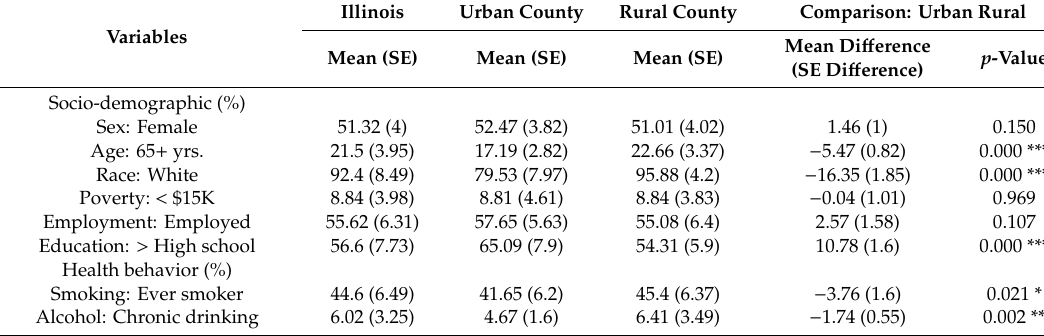
Table 1. Descriptive statistics and comparison between urban and rural counties in reported socio-economic status variables, health-related variables, and environmental characteristics: Illinois County Behavioral Risk Factor Surveys 2010–2014. ( n = 94).